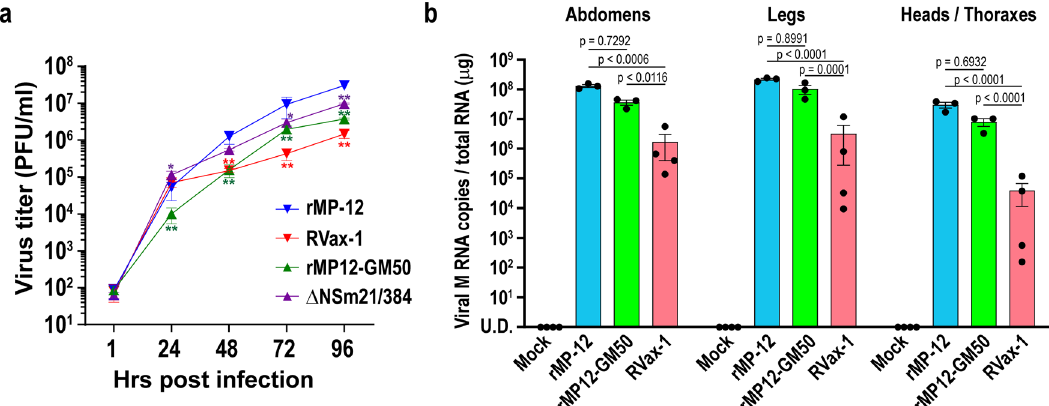
Fig. 2 Characterization of RVax-1 replication in mosquitoes. a C6/36 cells were infected with rMP-12, RVax-1, rMP12-GM50, or rMP12- Δ NSm21/384 at MOI 0.01. Virus replication kinetics at 28 °C are shown. The graph represents the means ± standard deviations of triplicate wells (two-way ANOVA; * p < 0.05, ** p < 0.01, vs. rMP-12, F = 13.47, df = 12). b Aedes aegypti were fed on blood meals containing medium (mock), rMP-12, rMP12-GM50, or RVax-1. Total RNA from abdomen, leg, or head/thorax/wing from three pools ( n = 10 per pool) of mosquitoes at 14 dpi in each group were used for qRT-PCR analysis. Copy number of viral M segment RNA was measured by Taqman qRT-PCR using the standard curve for in vitro synthesized RVFV M segment RNA. Means ± standard errors of three different pools are shown in a scattered dot plot graph (two-way ANOVA: F = 2.178, df =